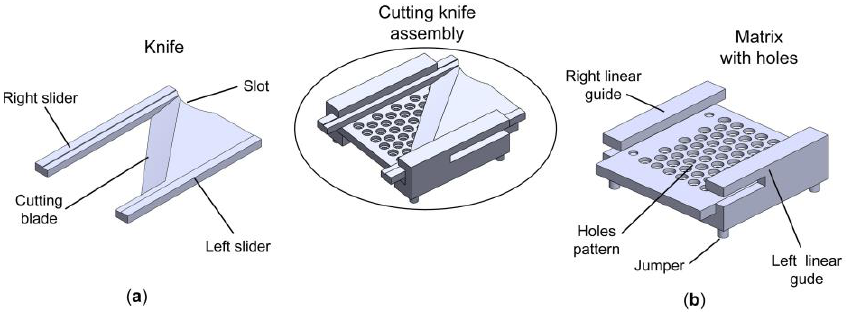
Figure 8. New design solution of cutting knife: ( a ) new design of knife/blade; ( b ) commercial grain-cutter matrix.